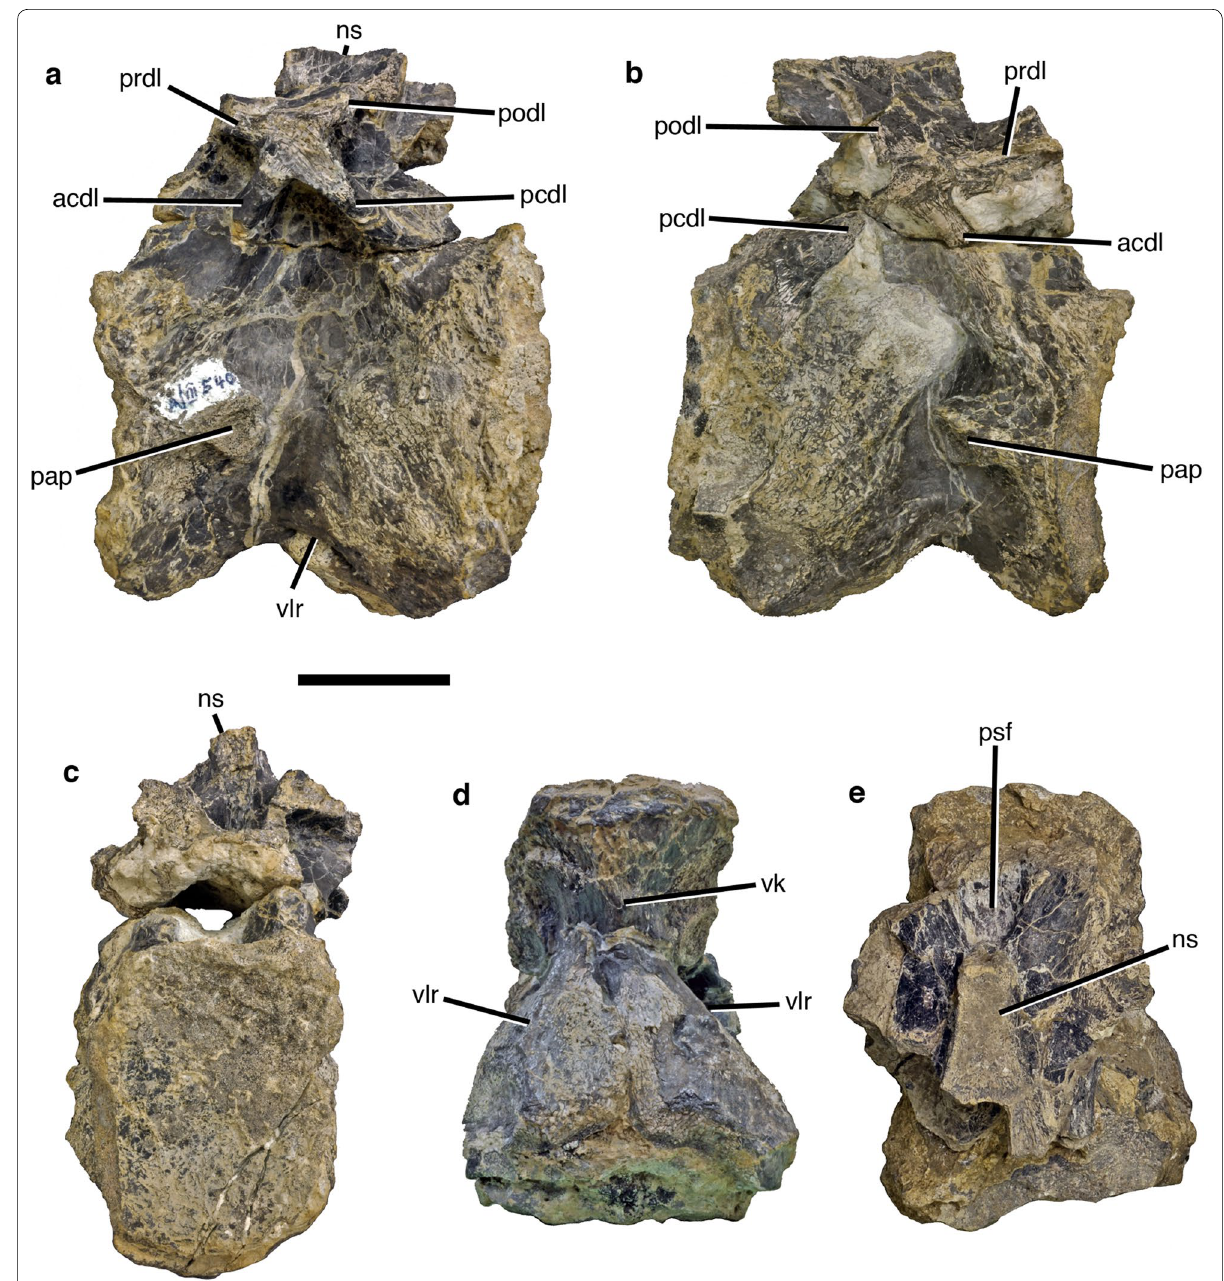
Fig. 4 Anterior dorsal vertebra of Schleitheimia schutzi n. gen., n. sp., PIMUZ A/III 540. a , b left and right lateral views; c anterior view; d ventral view; e dorsal view. acdl, anterior centrodiapophyseal lamina; nc, neural canal; pap, prapophysis; pcdl, posterior centrodiapophyseal lamina; podl, postzygapophyseal diapophyseal lamina; prdl, prezygodiapophyseal lamina; psf, prespinal fossa; spdl, spinodiapophyseal lamina; vk, ventral keel; vlr, ventrolateral ridge. Scale bar equals 5